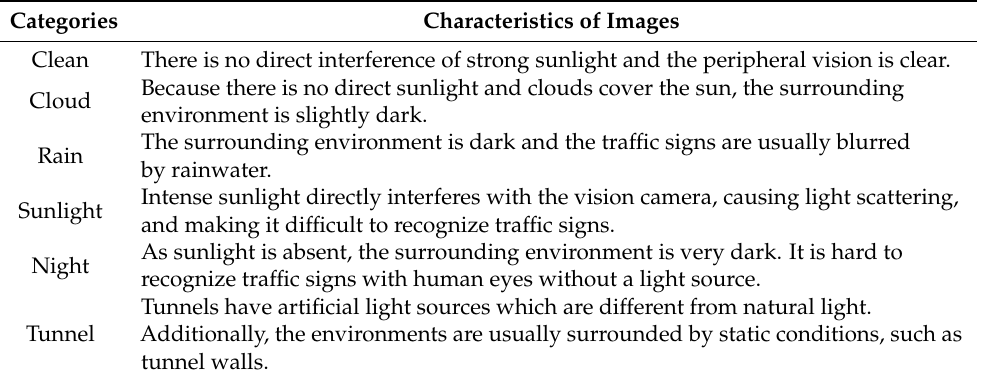
Table 1. Proposed categories for various urban environments.